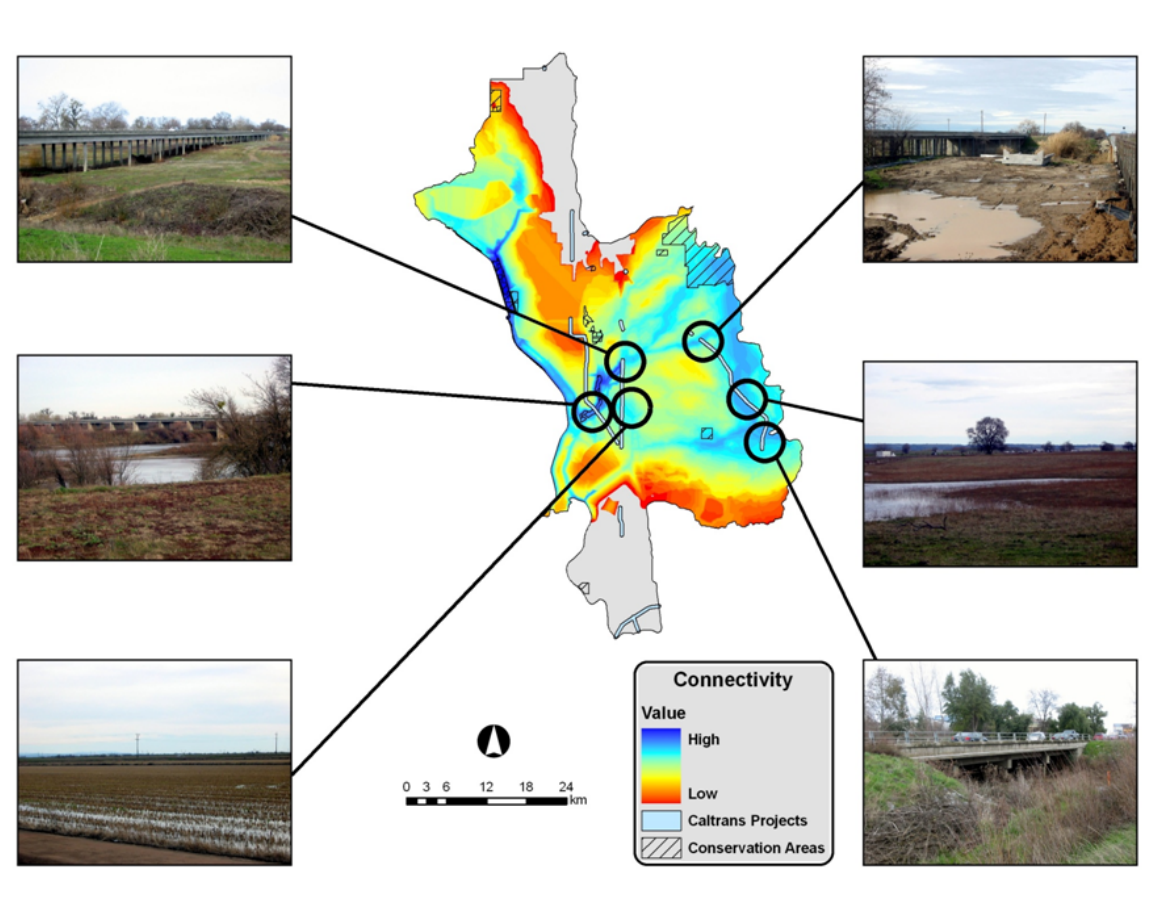
Fig. 8. Six locations of programmed road-construction projects that overlap modeled high connectivity areas. These identified locations could be considered for on-site mitigation measures (a regulatory preferable solution to potential environmental impact) designed to preserve or enhance regional connectivity. The photos reveal that these locations are frequently associated with bridges over riparian